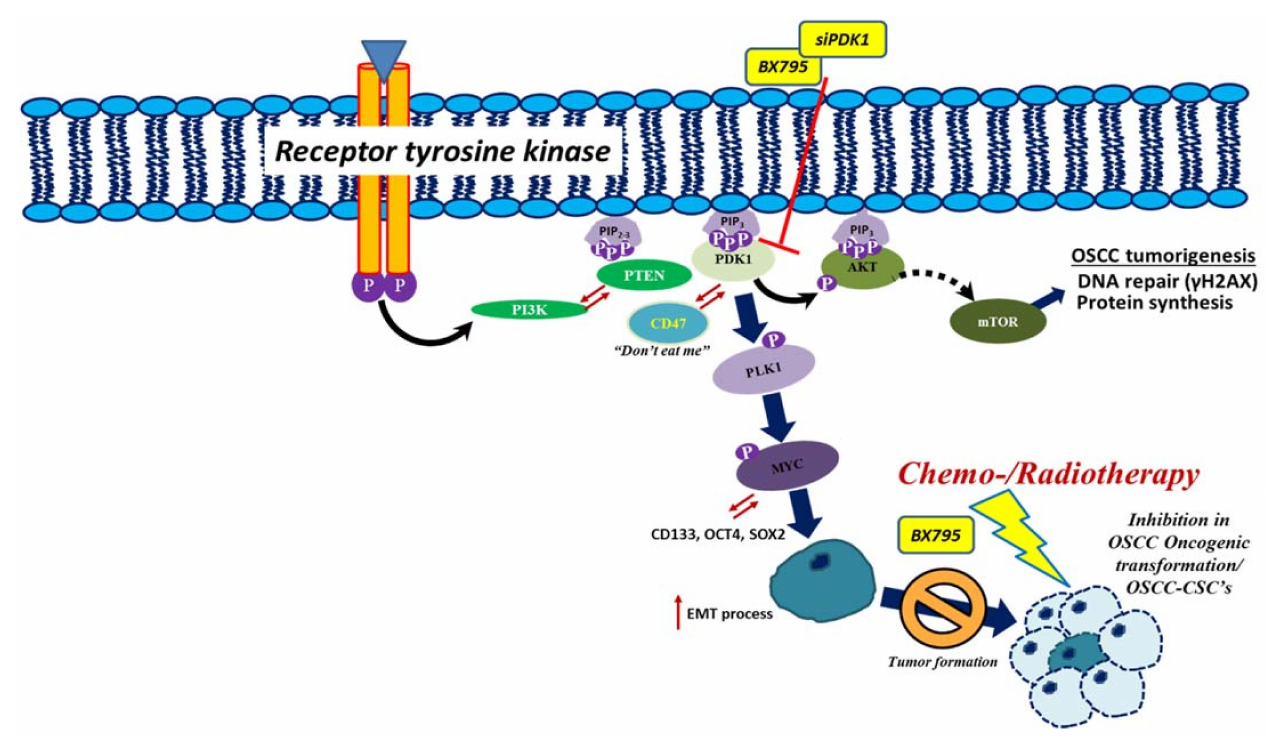
Figure 7. Graphical